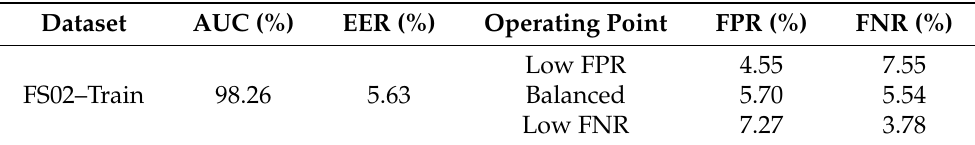
Table 7. AUC, EER, FPR and FNR on three operating points for the pseudo-labels obtained using the best performing model adapted through Log Deep CORAL method on FS02 training partition.